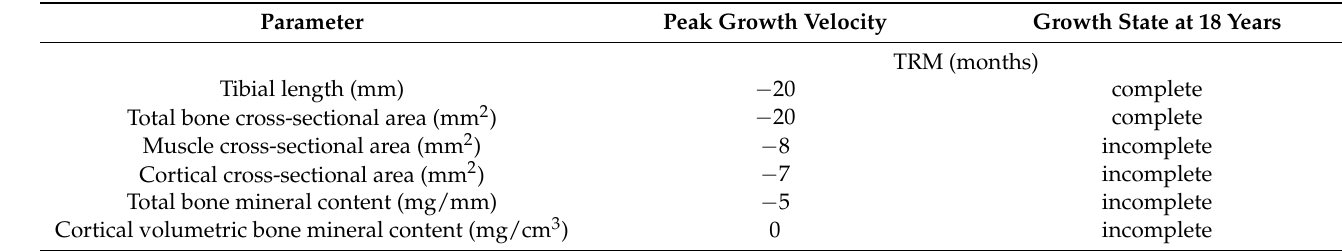
Table 1. Timing relative to menarche (TRM) of peak growth velocities of lower leg muscle and bone during puberty in girls [43].